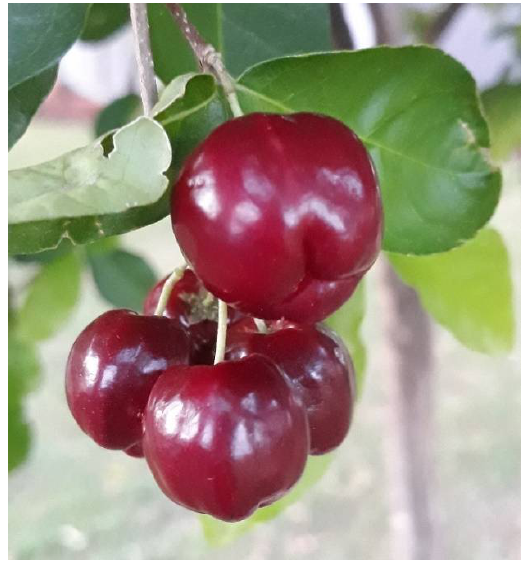
Figure 9. Ripe acerola fruits of phenotype number 37.